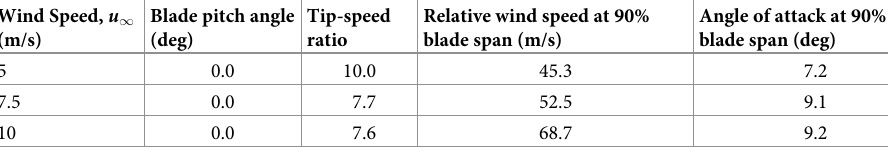
Table 2. NREL 5 MW turbine operating conditions